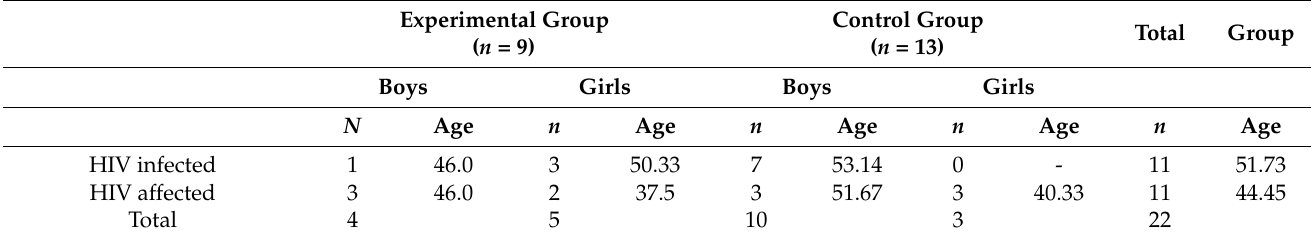
Table 1. Descriptive characteristics of the experimental and control